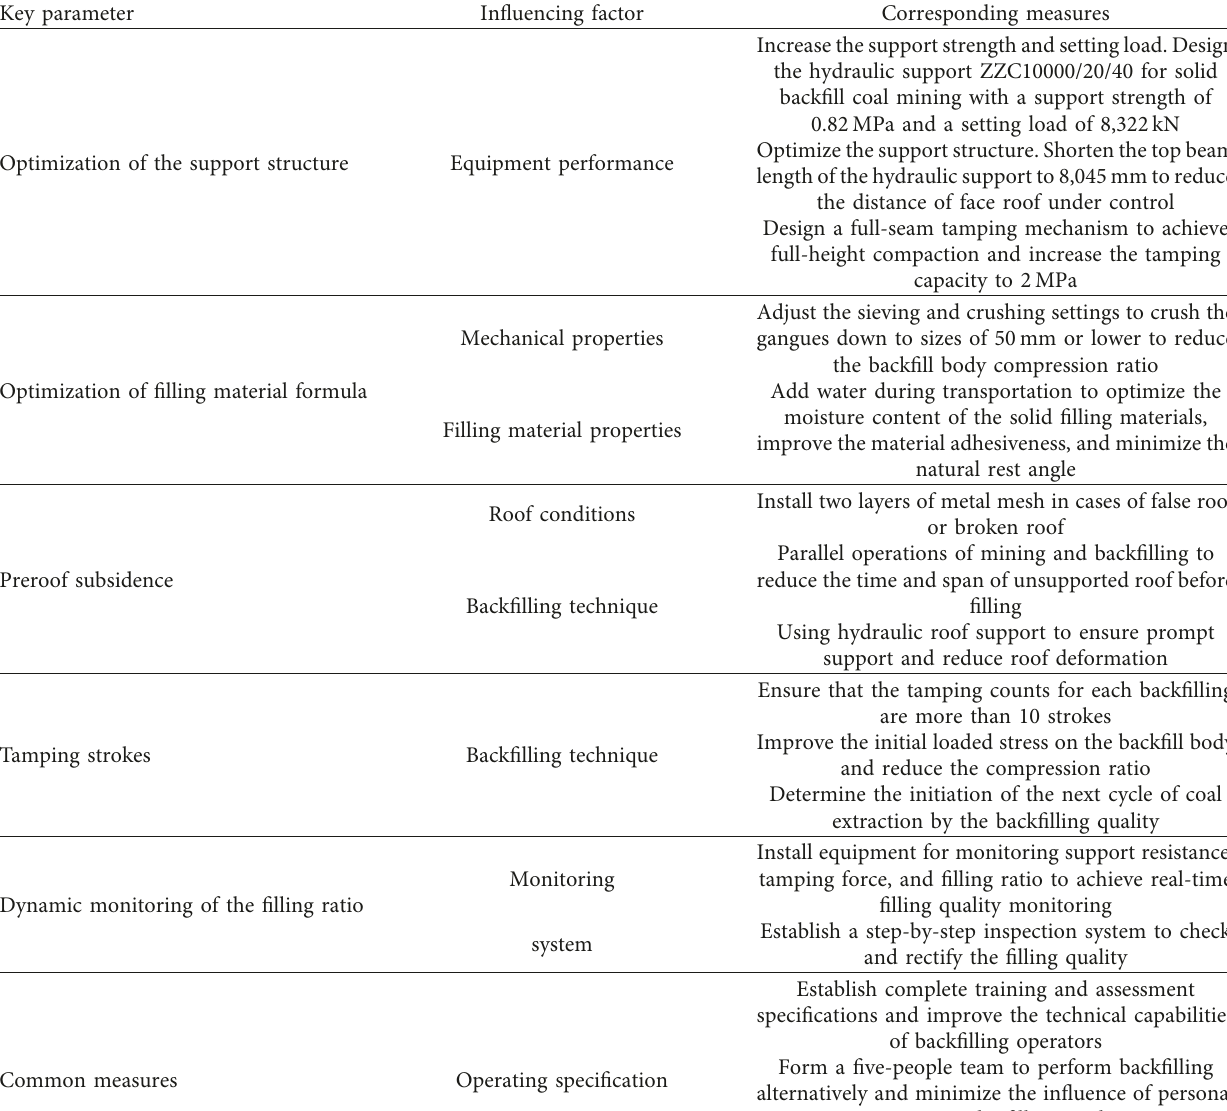
Table 1: Main methods of improving roof-controlled backfilling ratio. Key